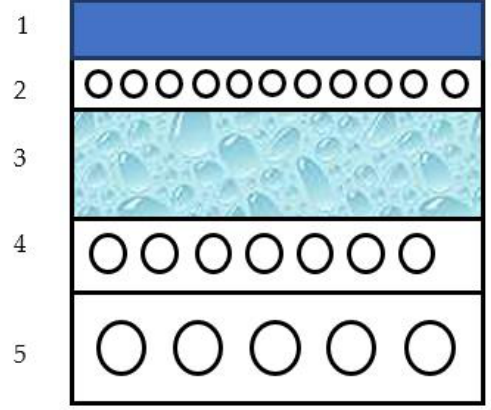
Figure 1. The structure of the multilayer rubber–fabric composite used for offset printing. 1—ink- transferring monolithic layer, 2,4,5—fabric layers, 3—foamed elastomer layer.